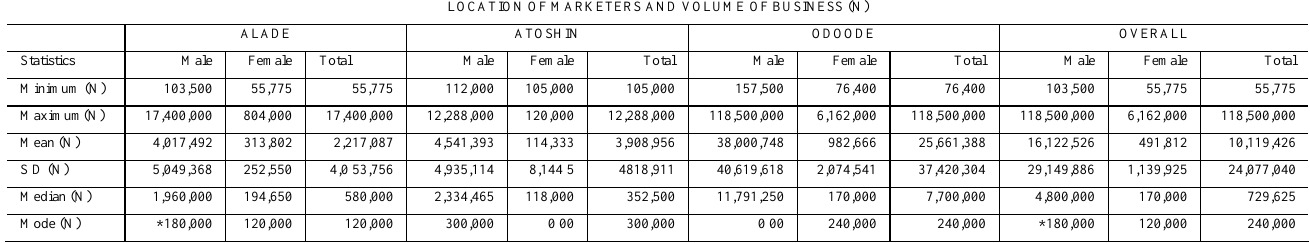
Table 4: Statistics of volume of business (N) by location and gender: Cocoa marketers in Idanre , Ondo State Nigeria. 2000/2001